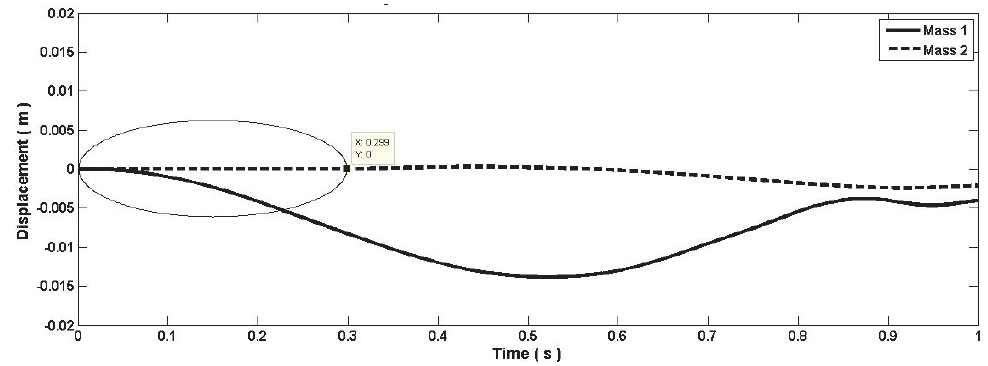
Figure 11: Delay of frame 2 behind frame 1 due to span (300m) and wave's velocity